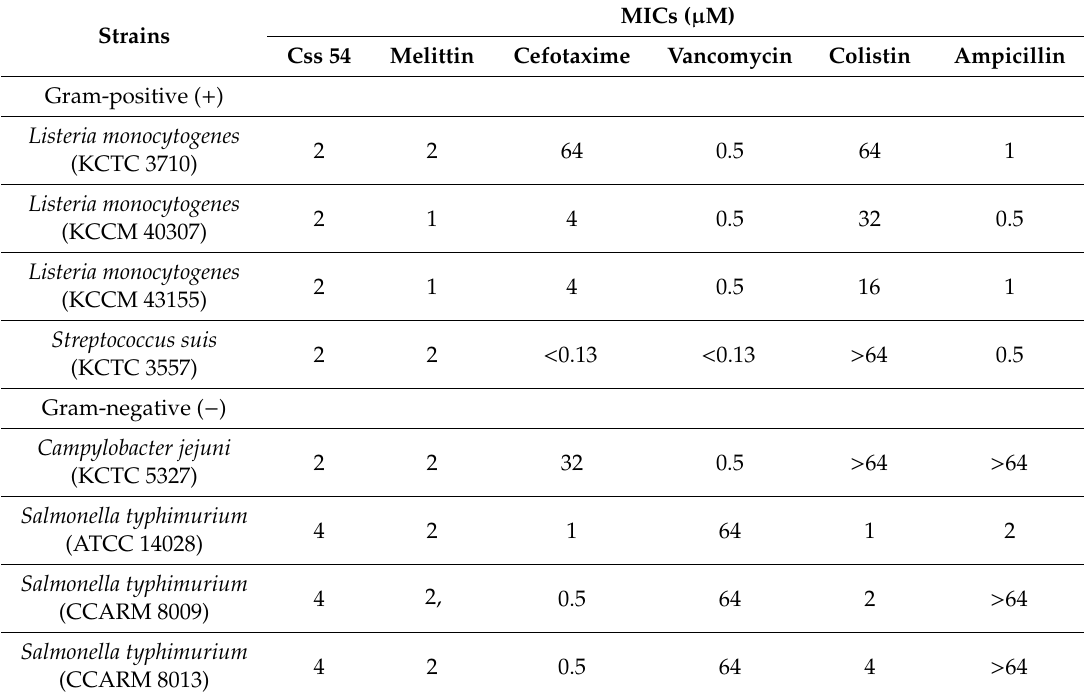
Table 2. Minimum inhibitory concentrations (MICs) of antimicrobial peptides and antibiotics against zoonosis